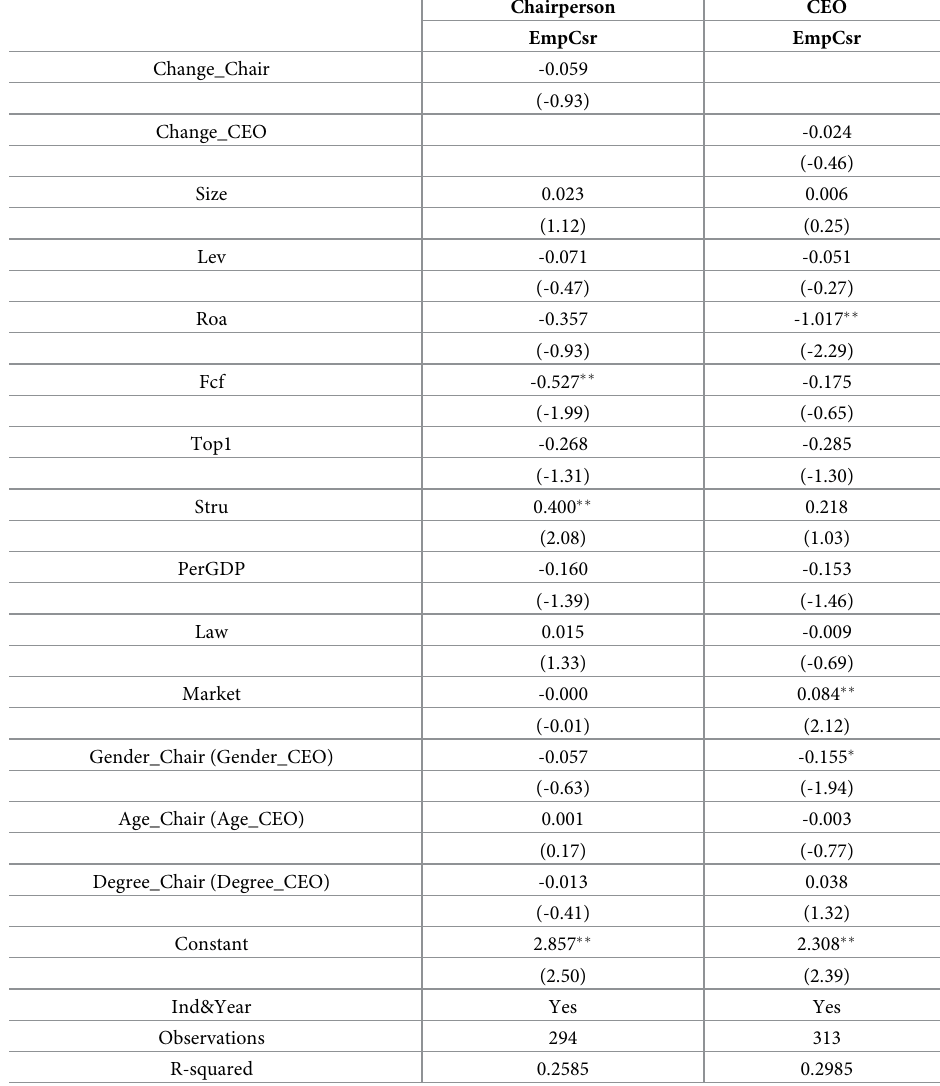
Table 6. Impacts of senior executive